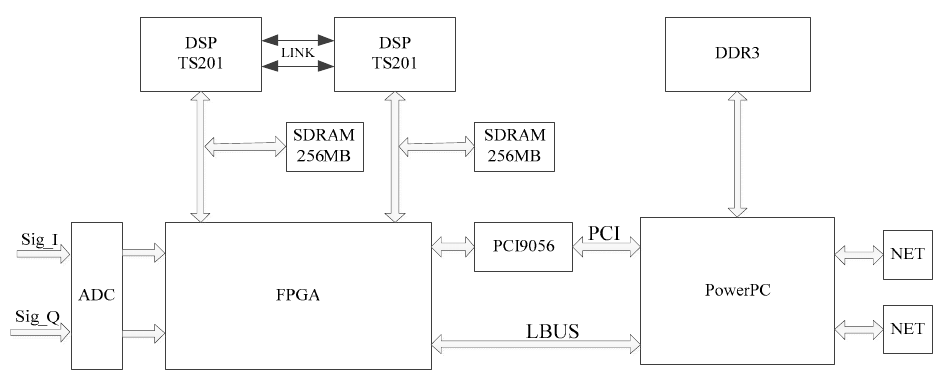
Figure 8. Signal processing board module diagram.